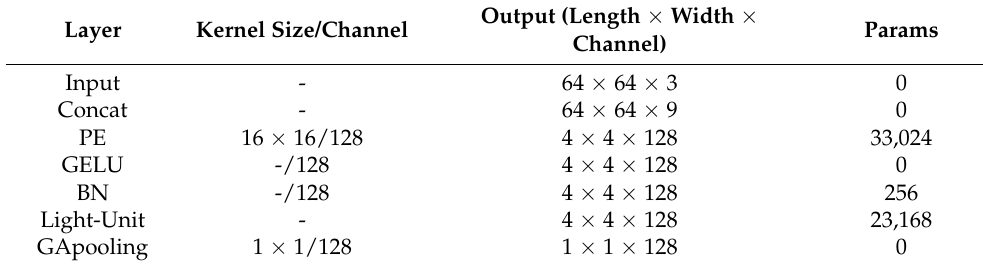
Table 1. Specific parameters of the proposed MCDS-CNN.